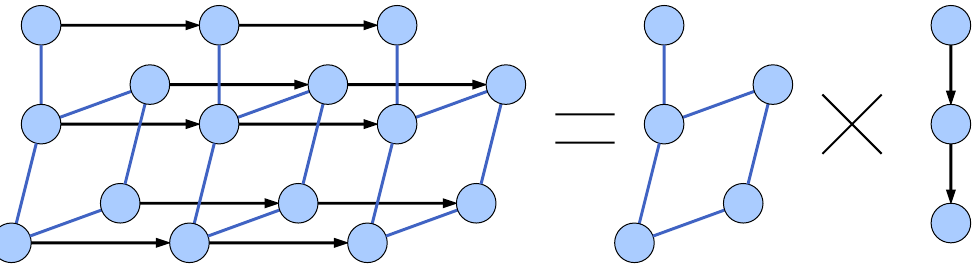
Figure 5. Sensor network measurements as a Cartesian product of sensor network and time se- ries